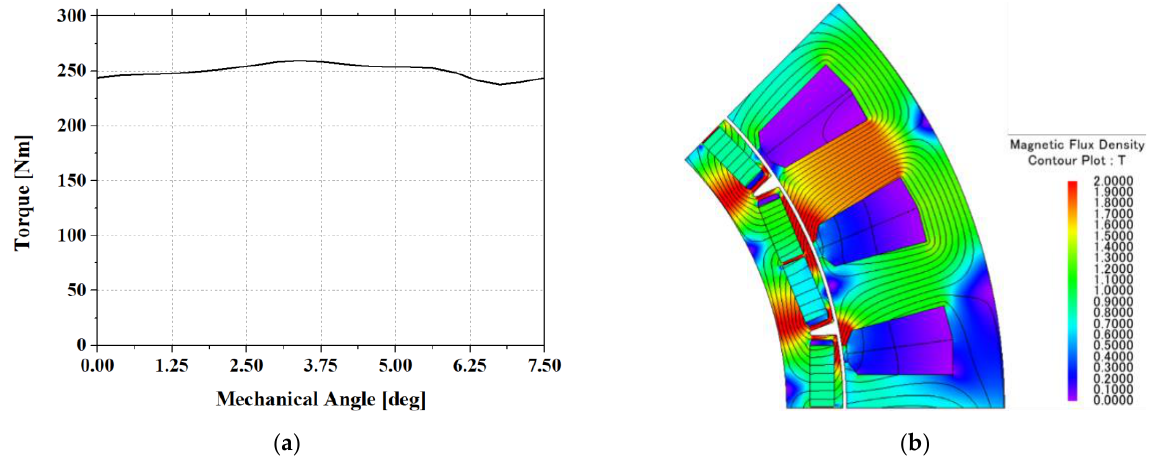
Figure 4. Waveform of torque, magnetic flux density, and magnetic flux line of the designed model in load condition. ( a ) Torque waveform of the designed model; ( b ) Magnetic flux density of the designed model.